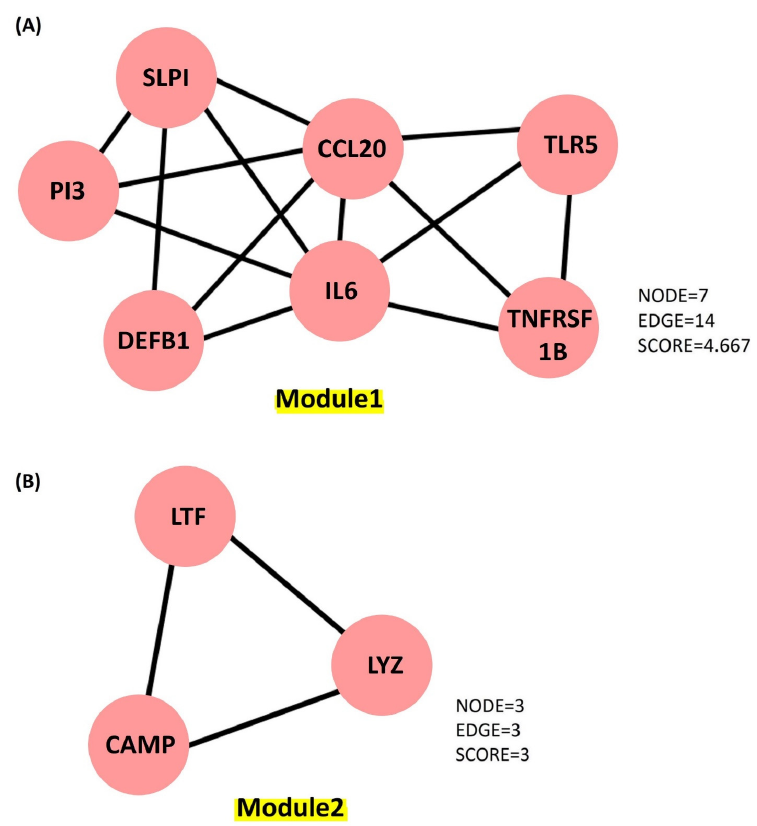
Figure 6. Key molecules identified from the PPI network generated using Cytoscape plugin MCOD. ( A ) Module 1 contains 7 proteins represented as 7 nodes and 14 edges, with a score of 4.667. ( B ) Module 2 contains 3 proteins represented as 3 nodes and 3 edges, with a score of 3.0.